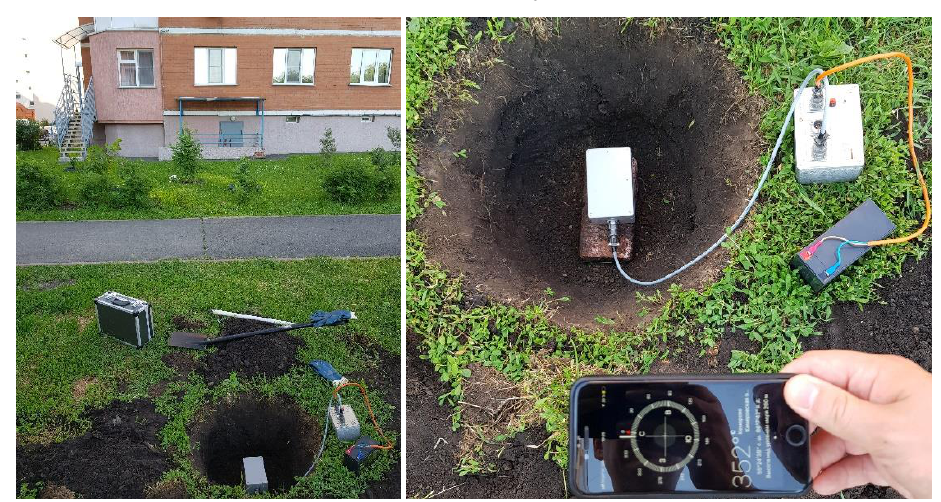
Fig. 3. An example of instrumental determination of the dynamic parameters of the subsoil and of the total structure for the studied residential high-rise building using the